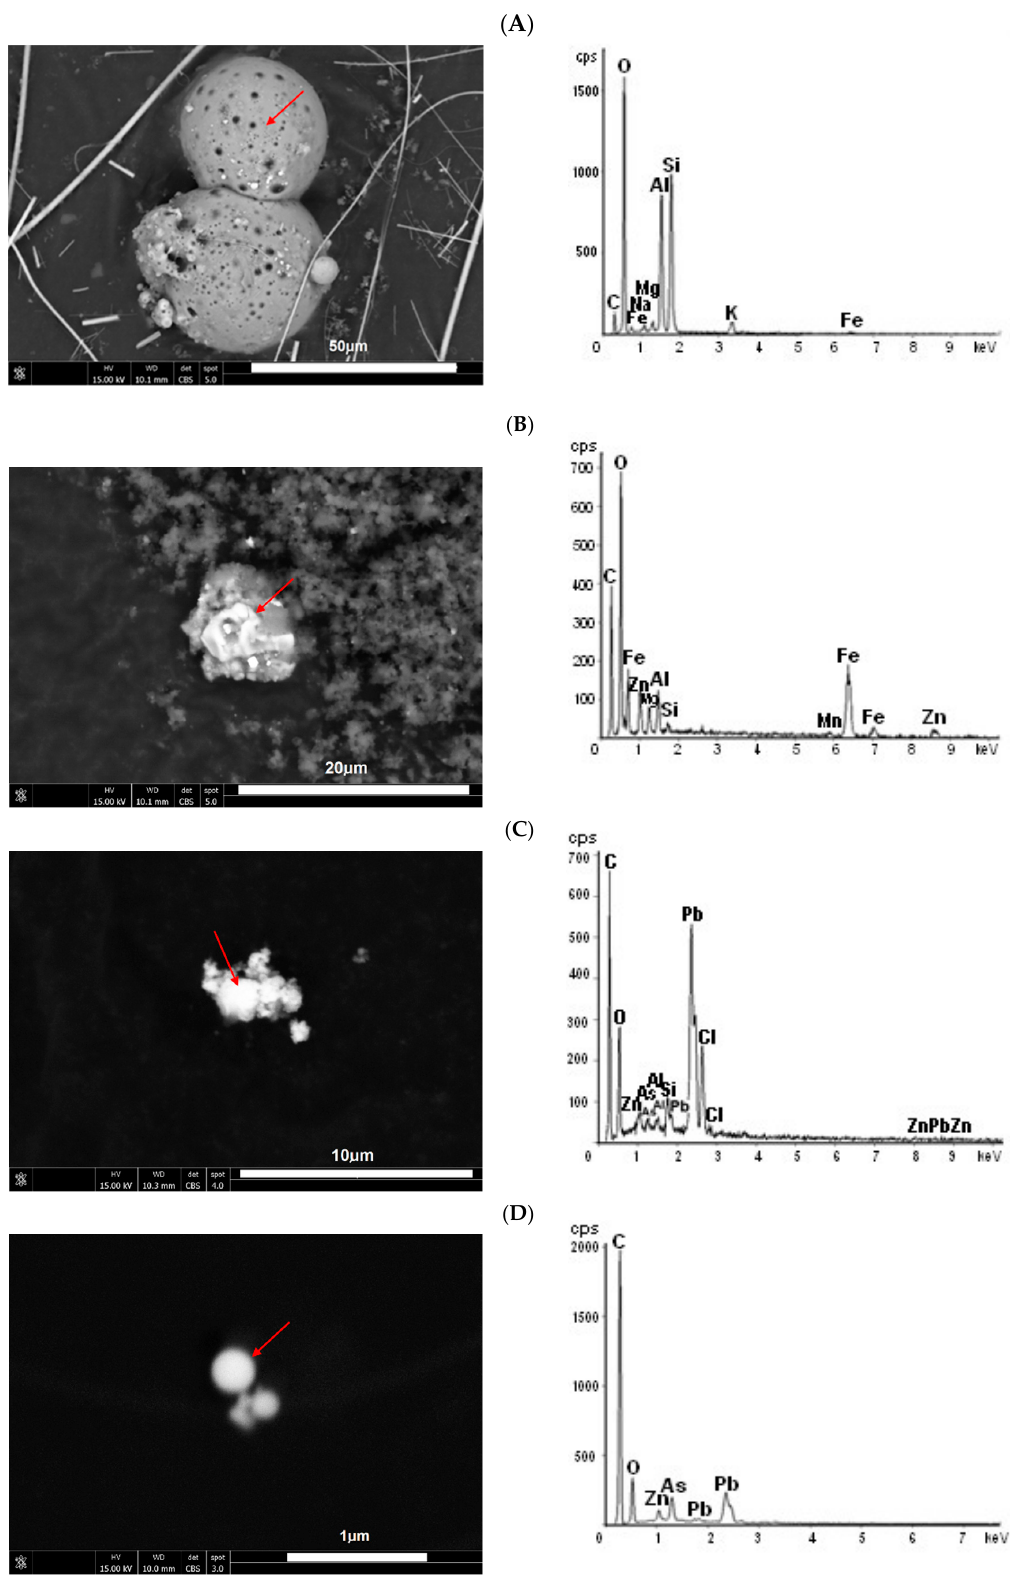
Figure 7. SEM images and related EDS spectra of TSP filters ( A – C ) and PM1 filter ( D ); red arrows show the points where presented EDS spectra have been performed (axes description: cps—counting per second;